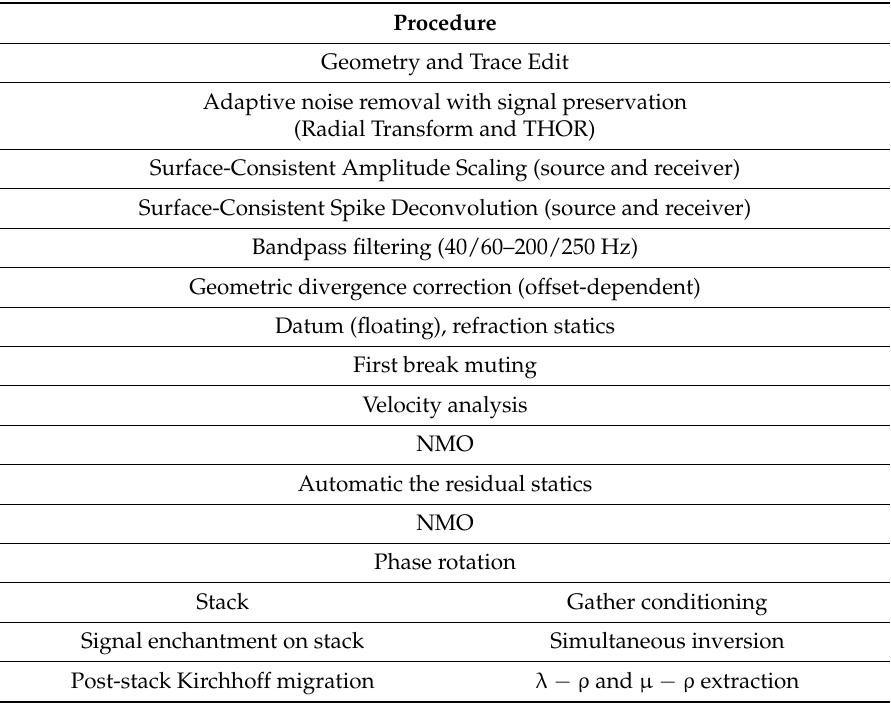
Table 2. Seismic data processing